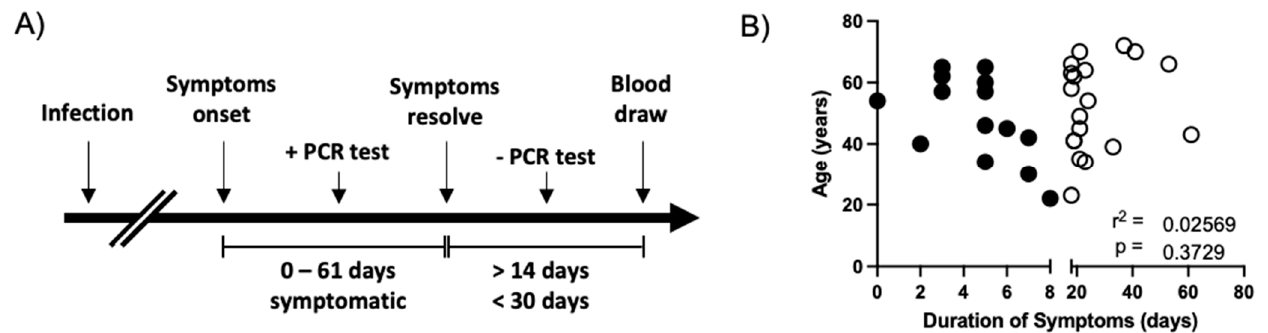
Table 1. Convalescent COVID-19 patient characterization.